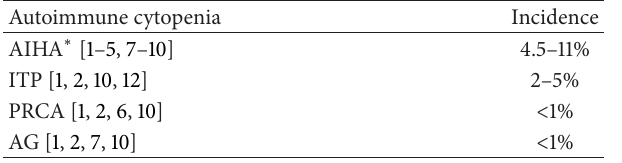
Table 2: Recommendations for the diagnosis of CLL-associated autoimmune